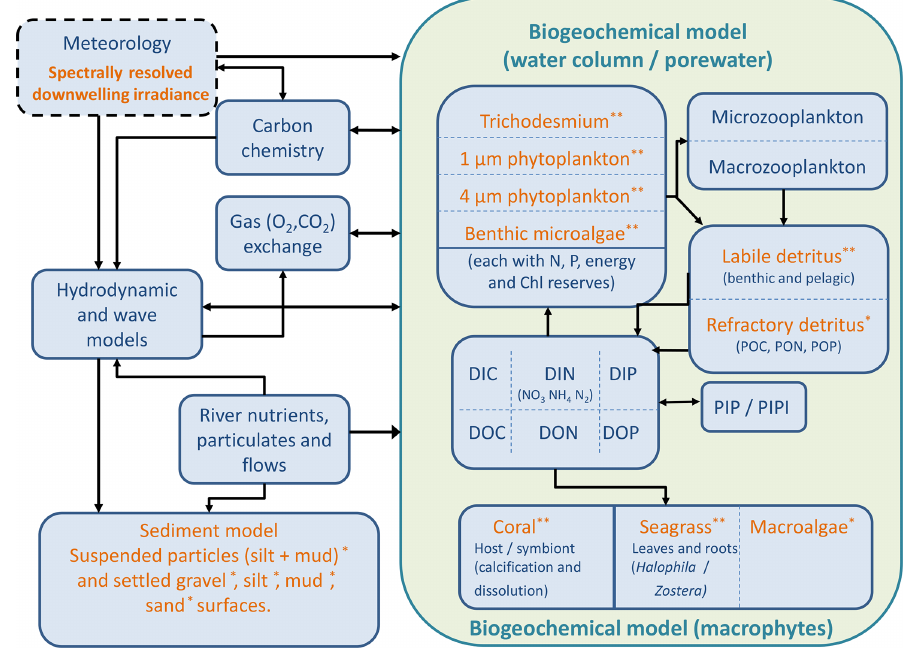
Figure 3. Schematic of the CSIRO Environmental Modelling Suite illustrating the biogeochemical processes in the water column, epipelagic and sediment zones, as well as the carbon chemistry and gas exchange used in vB3p0 for the Great Barrier Reef application. Orange labels represent components that scatter or absorb